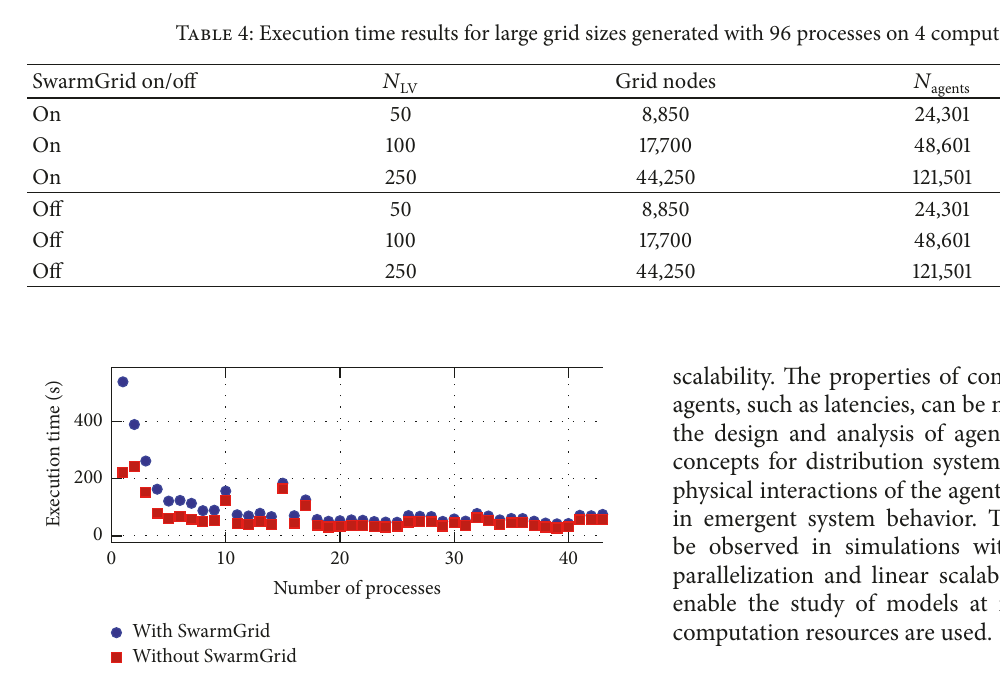
Figure 14: Execution time results of scenario with 𝑁